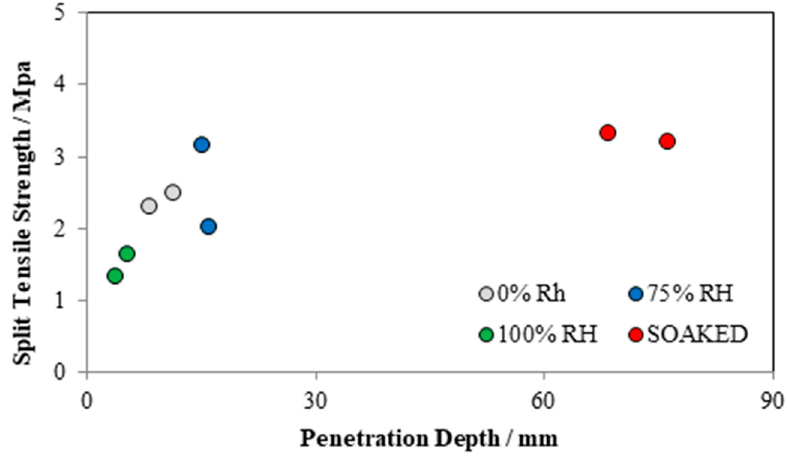
Figure 7. Chloride penetration depth for each exposure.